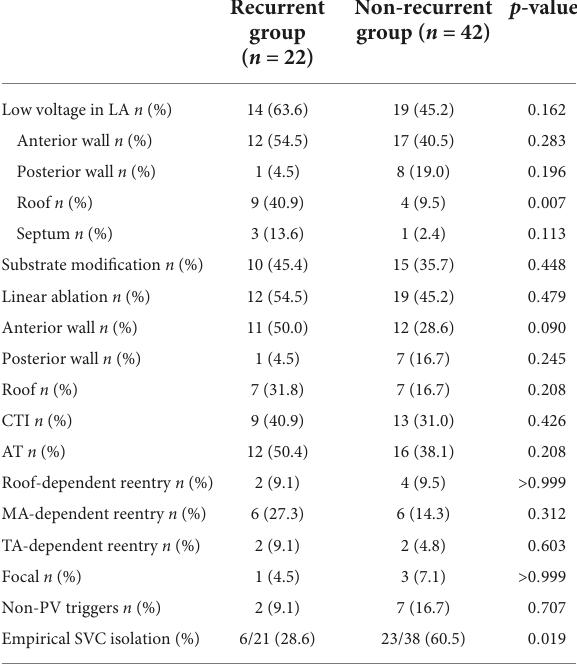
TABLE 3 Procedural characteristics of the recurrent and non-recurrent